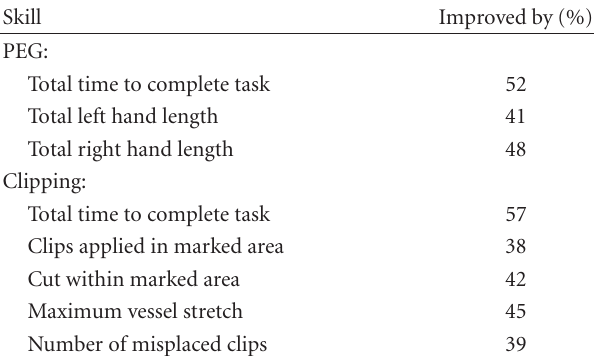
Table 2: Improved parameters after the